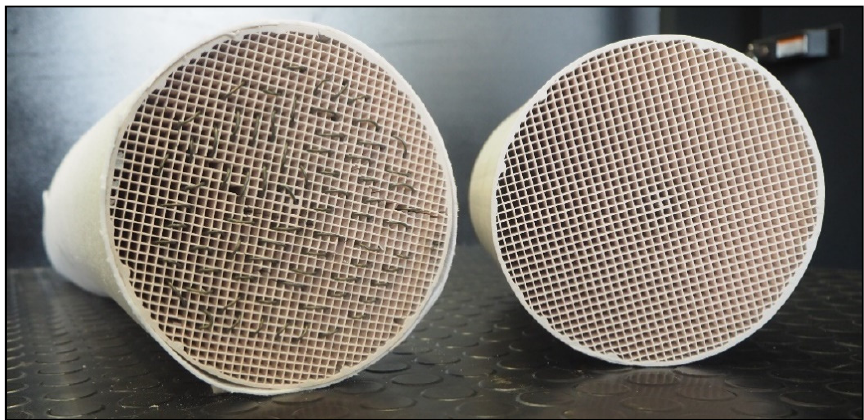
Figure 2. Ceramic honeycombs without ( right ) and with integrated heating wires ( left )—dimensions: diameter of 155 mm with a total length of 566 mm.